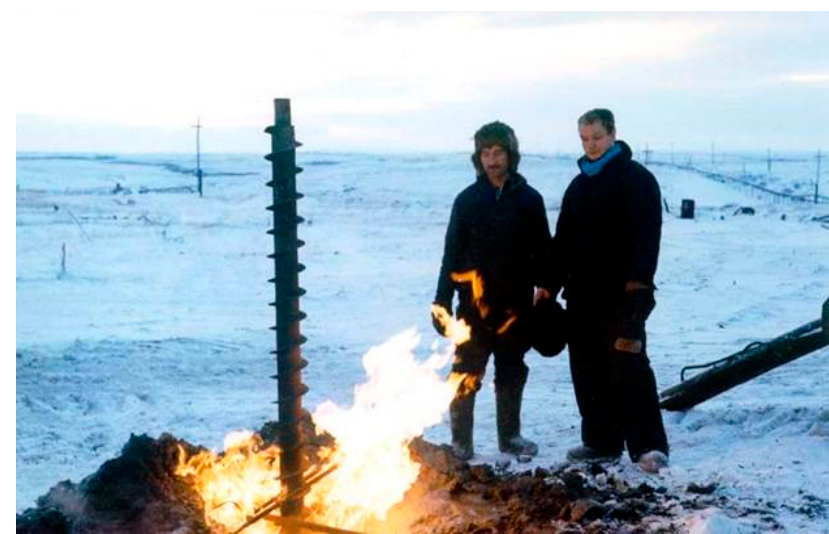
Figure 8. Methane emission from depths of 20–30 m during drilling of geotechnical boreholes in Pelyatka gas–condensate field (Gydan Peninsula, number on the map: 17).